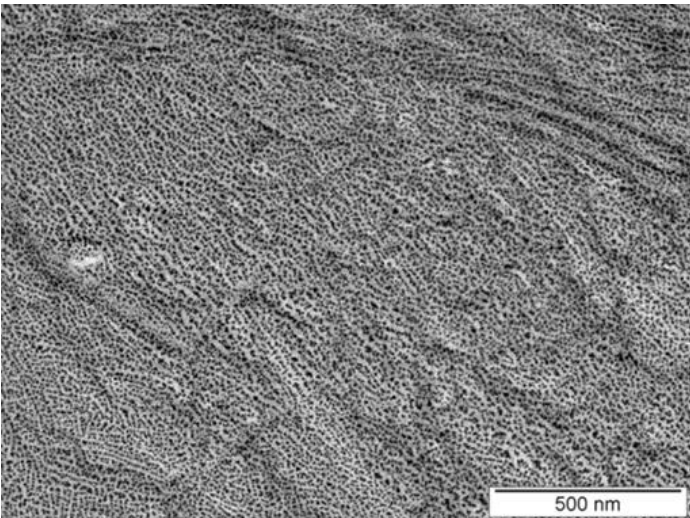
Figure 9. TEM bright-field image of gold-decorated thin films of the sample PE-b-sPP-1 with f sPP = 53% slowly crystallized from the melt.